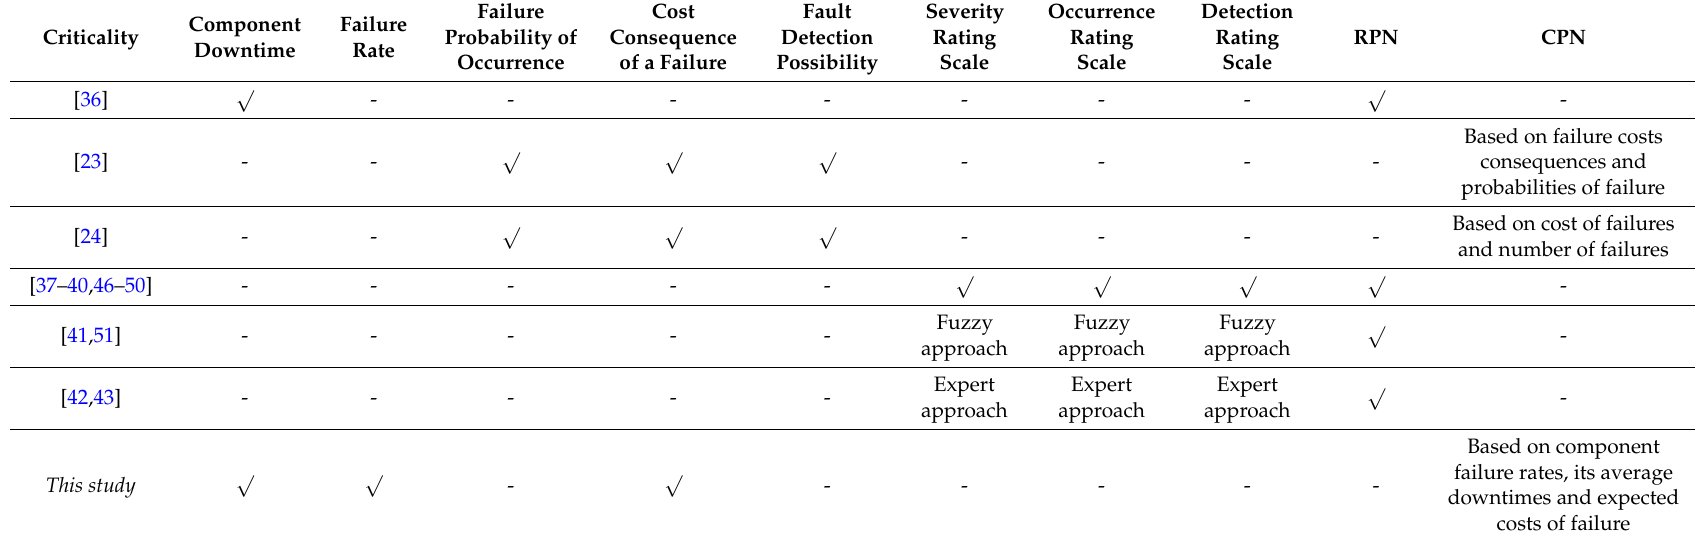
Table 2. Criticality assessment according to authors. RPN: risk priority number; CPN: cost priority